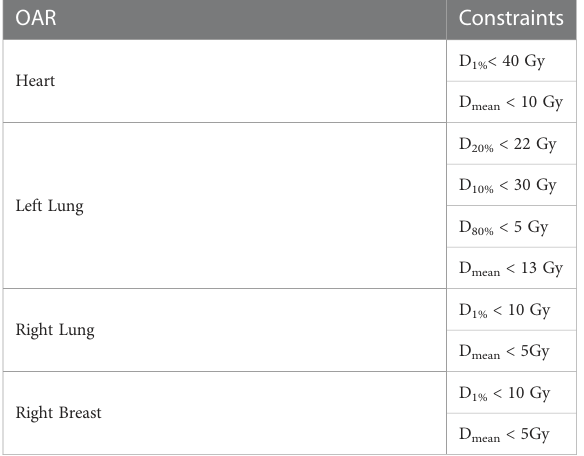
TABLE 1 Dose constraints for the indicated organs at risk.